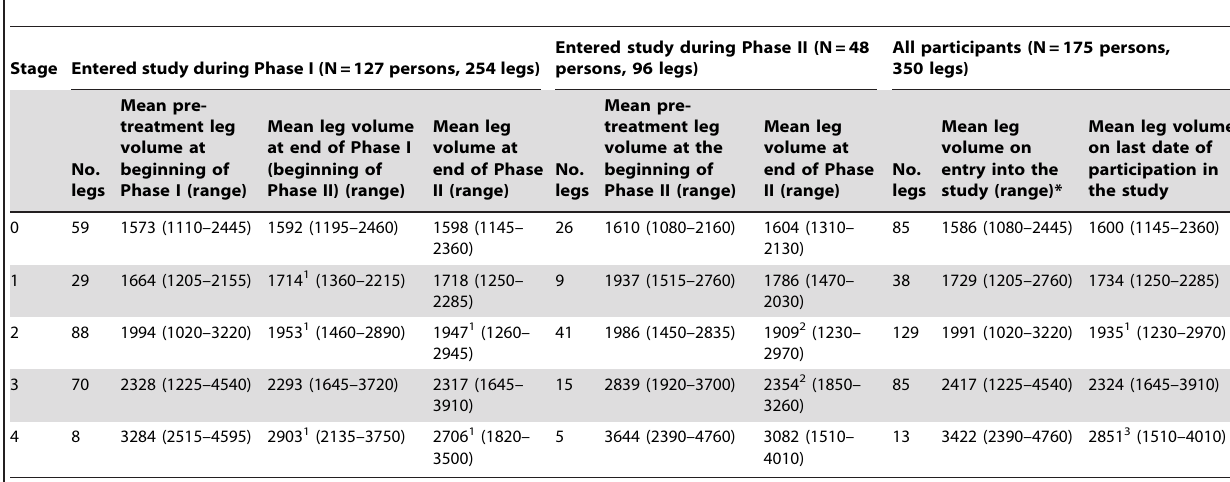
Table 4. Mean leg volume, in mL, among lymphedema patients in Leogane, Haiti, a) upon study entry, b) at the beginning of Phase II, and c) at the end of the study, by lymphedema stage and phase during which the patient entered the study.